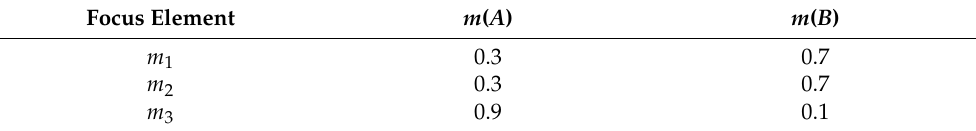
Table 1. Examples of high-conflict and high-clarity evidence.